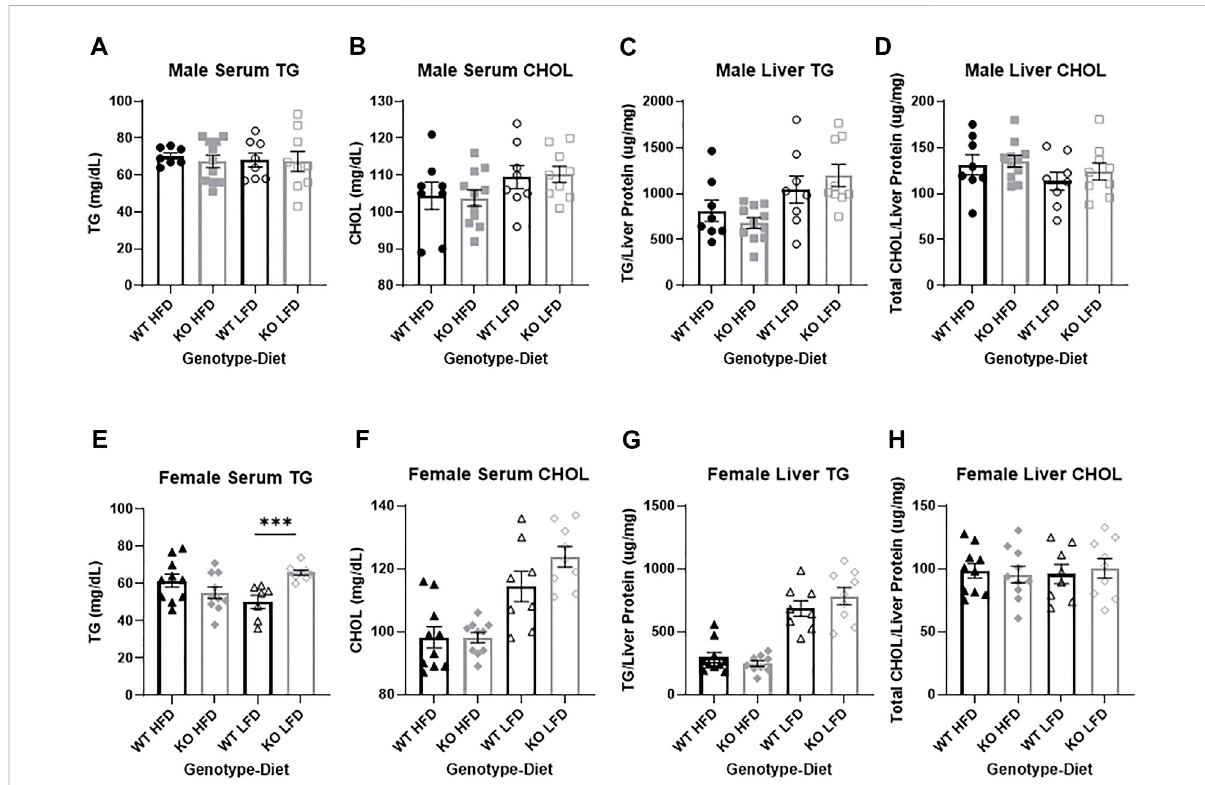
FIGURE 8 No differences in liver metabolic health between wild-type (WT; black) and Krtcap3 knock-out (KO; gray). Triglycerides (TG) and total cholesterol (CHOL)weremeasuredinserumcollectedfrommale(top)andfemale(bottom)rats.TherewasnodifferencebetweenWTmales(circle) and KO males (square) on a high-fat diet (HFD; fi lled) or a low-fat diet (LFD; empty) for (A) serum TG or (B) serum CHOL. TG and CHOL were also measuredinlivertissueofmalerats,withnodifferencesbetweenWTandKOmalesfor (C) liverTGor (D) liverCHOL. (E) Therewasagenotype- by-dietinteractioninserumTGinfemalerats,suchthatwhiletherewasnodifferencebetweenWT(triangle)andKOfemales(diamond)onaHFD,KO females had increased serum TG compared to WT on a LFD. *** p < 0.001 for an effect of genotype in the LFD condition. (F) There were no differences in serum CHOL between WT and KO females. There were no differences in (G) liver TG nor (H) liver CHOL between WT and KO females. Diet effects are reported in the “ Results ”